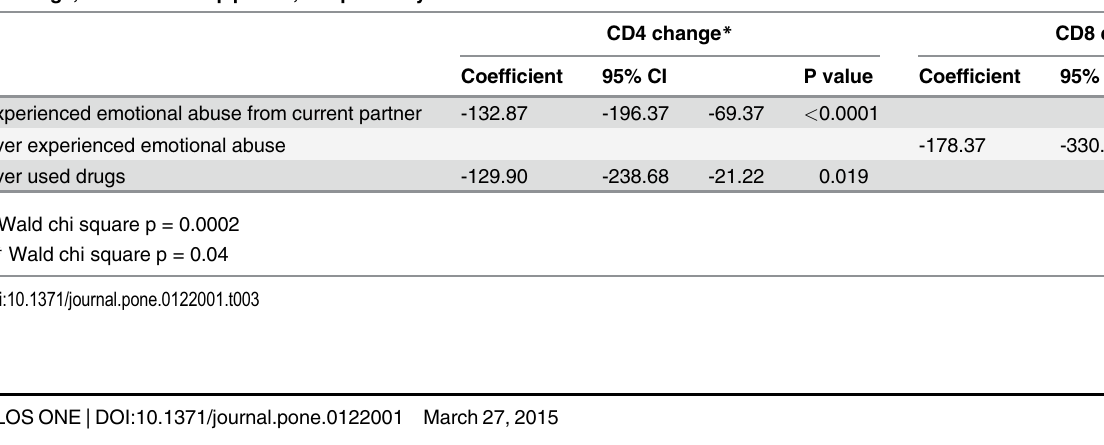
Table 3. Multivariable models of social factors, mental health and partner violence exposures associated with change in CD4/CD8 (models adjust- ed for age, CD4/8 follow up period, HIV positivity at